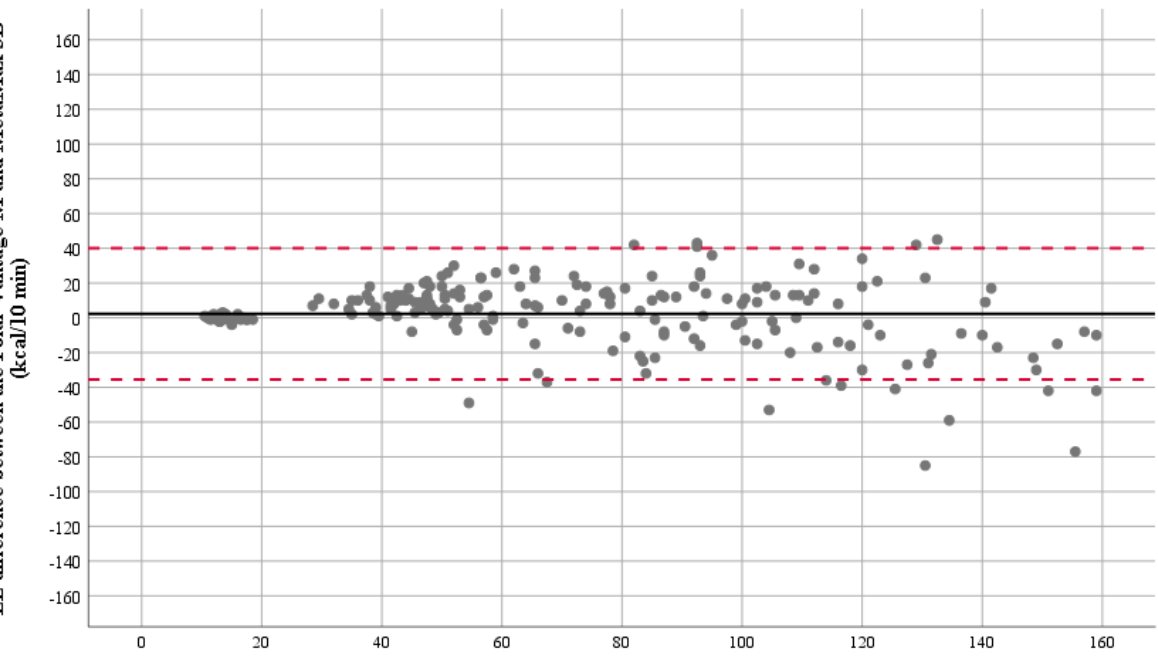
Figure 1. Bland and Altman plot of the energy expenditure (EE) estimation obtained during the 7 activity tasks (208 measurements). The solid line represents the systematic bias; the dashed lines represent the limits of agreement (systematic bias, SD 1.96).